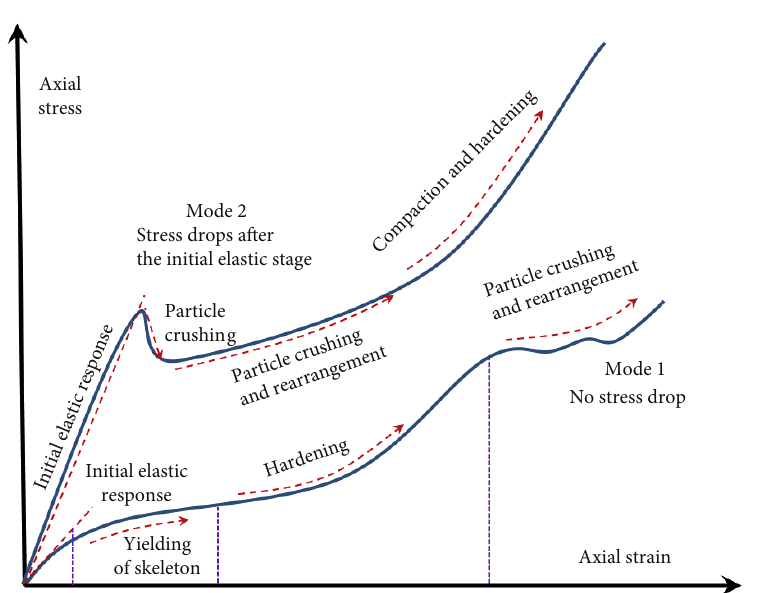
Figure 9: Stress-strain curve of dry sand under uniaxial strain loading (redraw from [38,